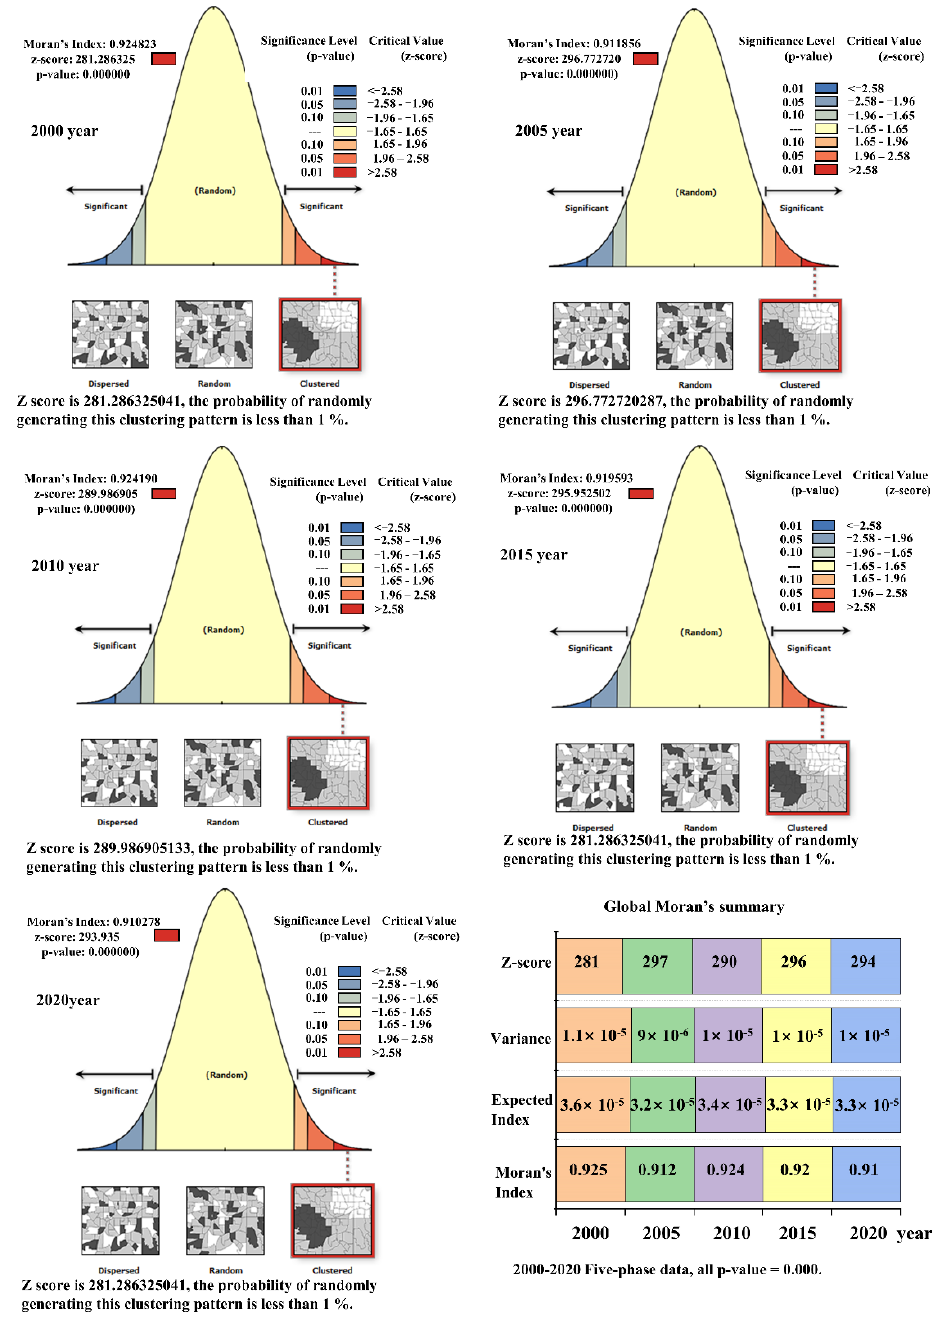
Figure 4. Five-period data Global Moran’s I